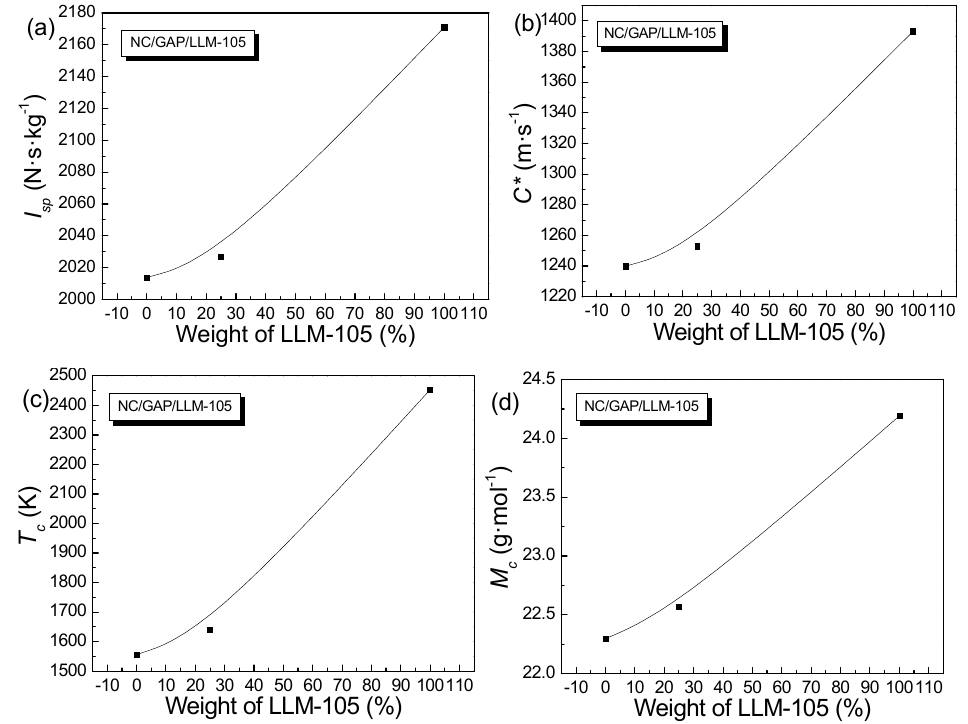
Figure 10. Energy performances of NC/GAP/LLM-105 nanofibers as a function of the weight percentage of LLM-105: ( a ) for I sp ; ( b ) for C* ; ( c ) for T c and ( d ) for M c .